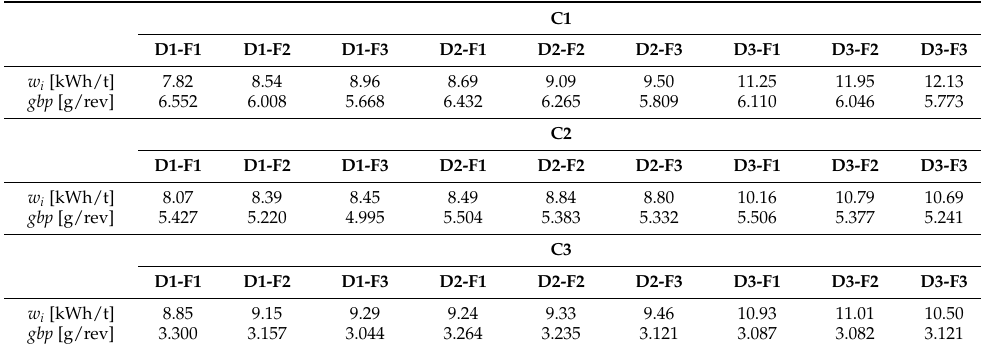
Table 3. Experimental results of w i and gbp